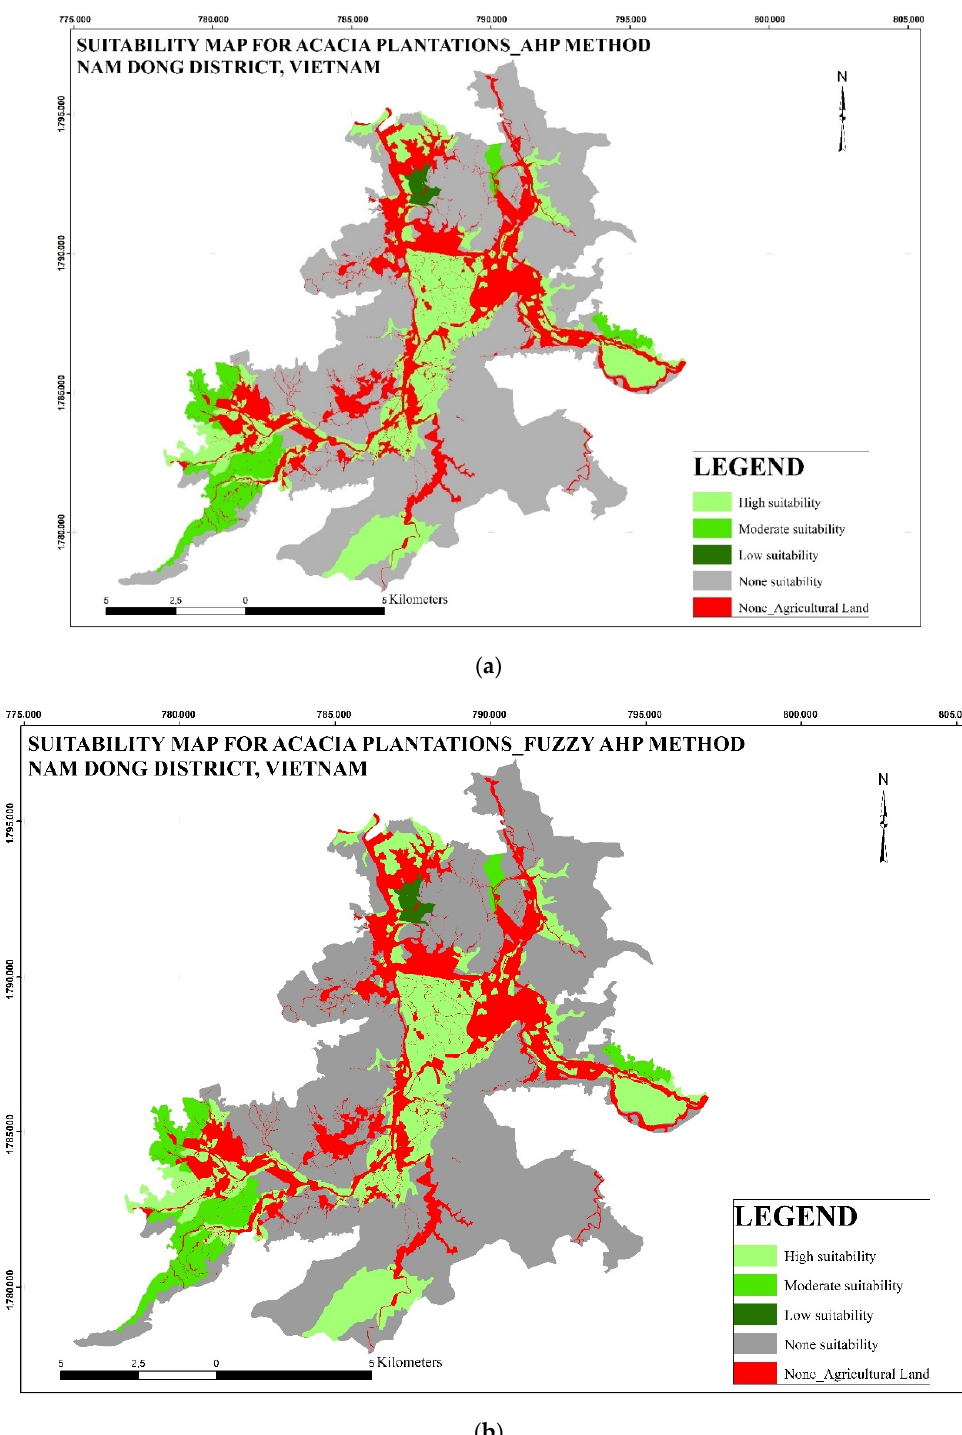
Figure 5. ( a ) Suitability map for acacia plantation by the AHP method. ( b ) Suitability map for acacia plantation by FAHP